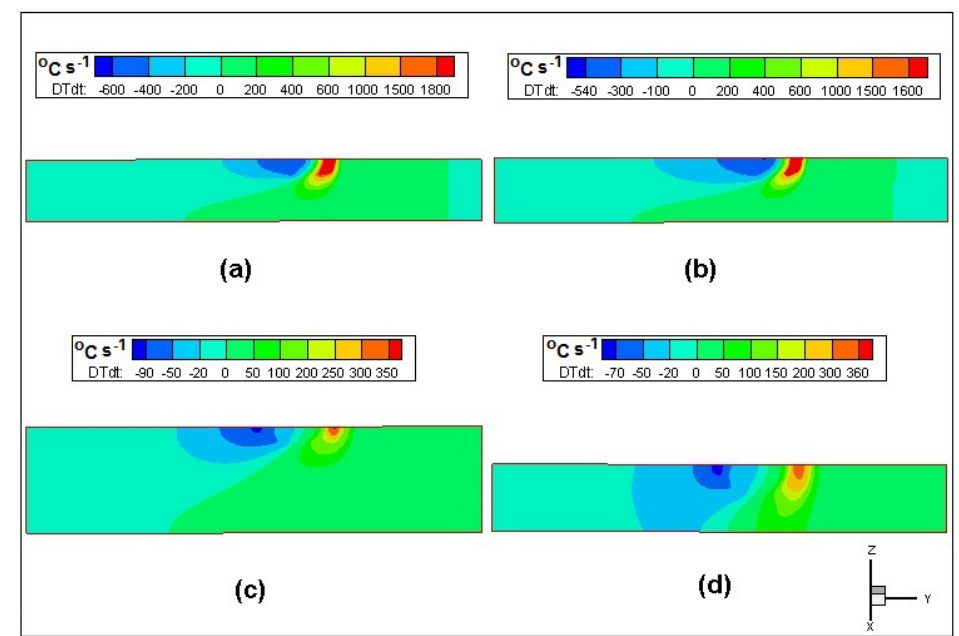
Figure 8 - Cooling and heating rates (oC s-1): (a) 0.5 kJ mm -1 and 10 mm thick (after 10.8 s); (b) 0.5 kJ mm -1 and 10 mm thick plus preheating (after 10.8 s); (c) 3 kJ mm -1 and 25 mm thick (after 55.4 s) and (d) 3 kJ mm -1 and 10 mm thick (after 55.4